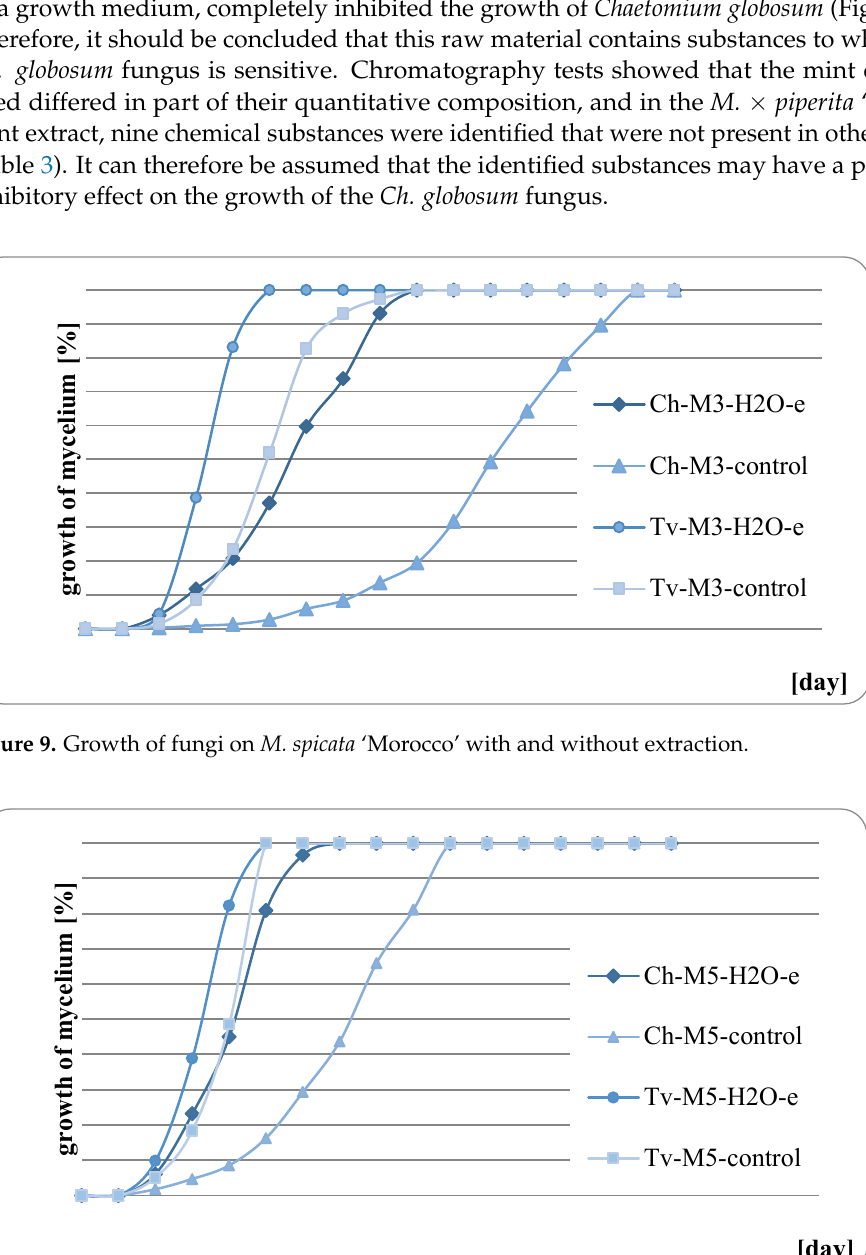
Figure 11. Growth of fungi on M. × piperita ‘Almira’ with and without extraction. Figure 12. Growth of fungi on M. suaveolens ‘ Variegata ’ with and without extraction. Using the GC-MS technique, the characteristics of the substance composition in the extract water are presented (Figure 13, Table 3). Menthol was the predominant component in the M. spicata ‘Morocco’ and M. spicata ‘Crispa’ extracts. High carvone concentrations were identified in all of the analyzed extracts. Three components ((S)-cis-Verbenol, Isocar- yophyllene, .alpha.-Bourbonene) were identified in the M. suaveolens ‘ Variegata ’ extract, which were not found in the remaining mints. The greatest differences in the chemical